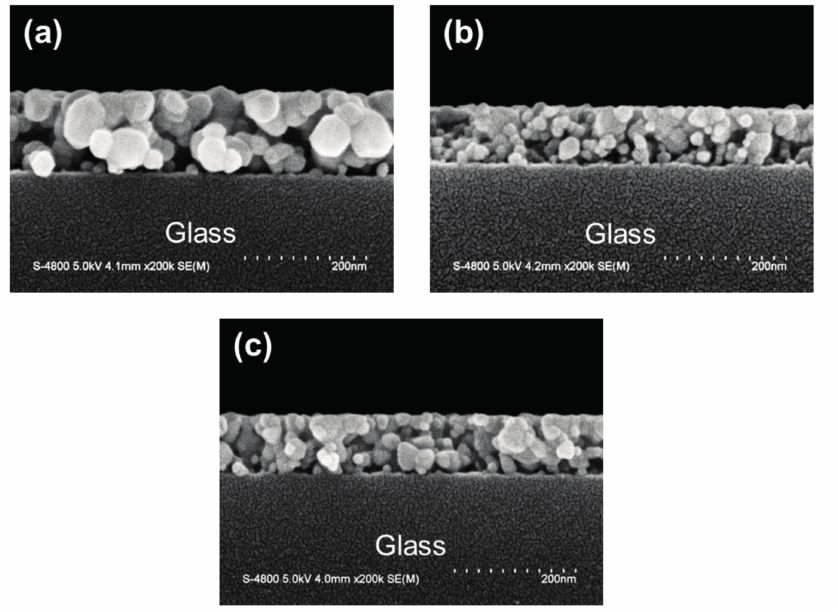
Figure 3. Cross-sectional scanning electron microscope (SEM) micrographs of ZnO-based thin films. ( a ) ZnO; ( b ) AZO; and ( c ) GZO thin